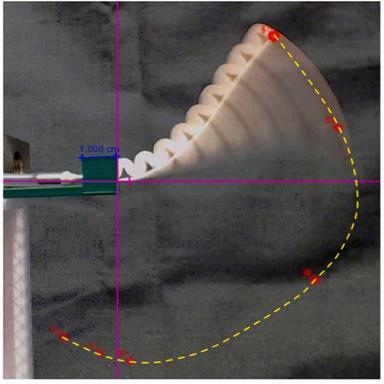
Dynamic displacement analysis under 10 psi, 5 Hz, and unload condition. The trajectory of the tip of the actuator is described by the yellow dotted line.